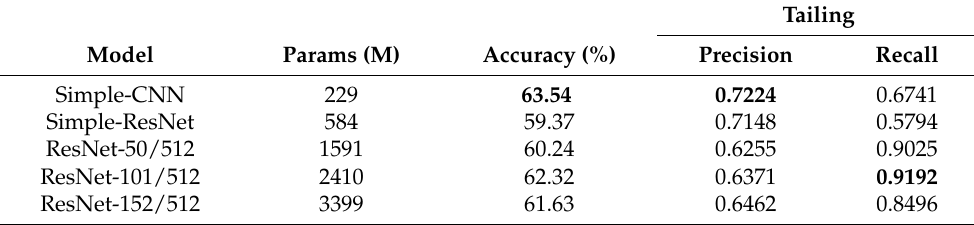
Table 1. Tailing detection performance comparison among different CNN architectures.